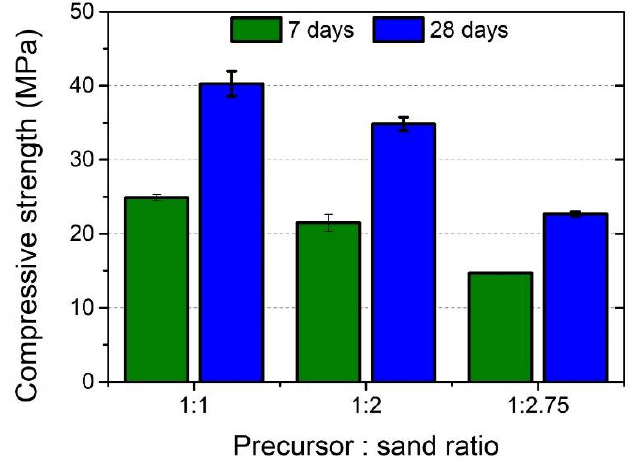
Figure 9. Compressive strength of mortars based on the optimal hybrid cement (90% FA–10% OPC, Si/Al 5.5 and Na/Si 0.14): effect of precursor:sand ratio.